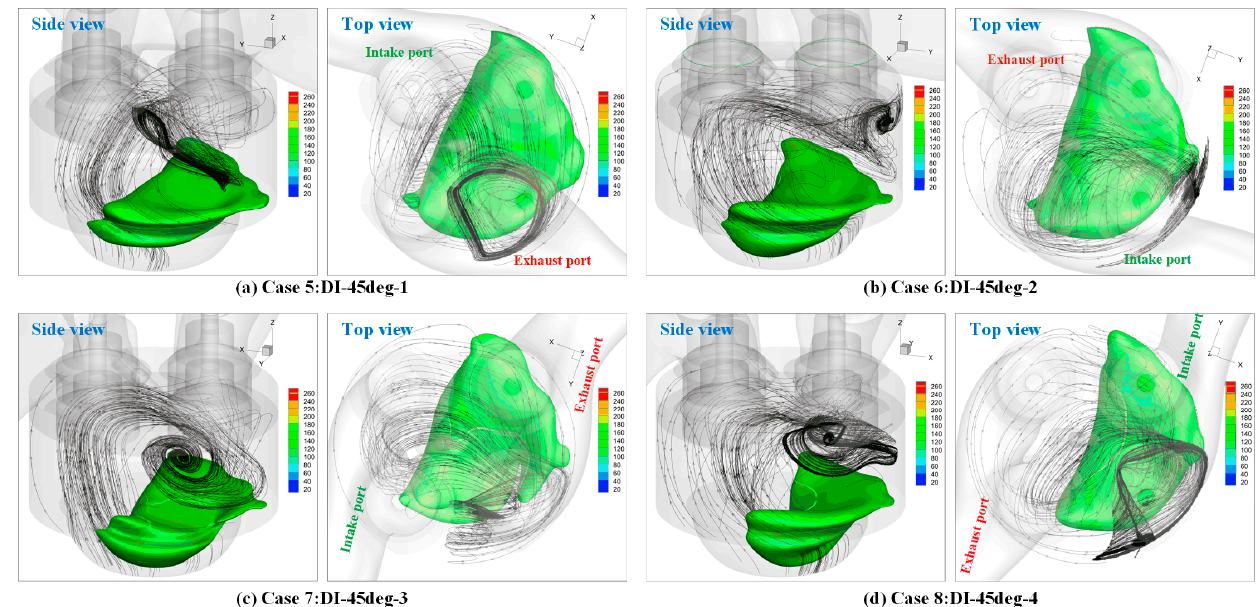
Figure 9. The in-cylinder TKE iso-surfaces (150 (m 2 /s 2 )/kg) and streamline at CA650.